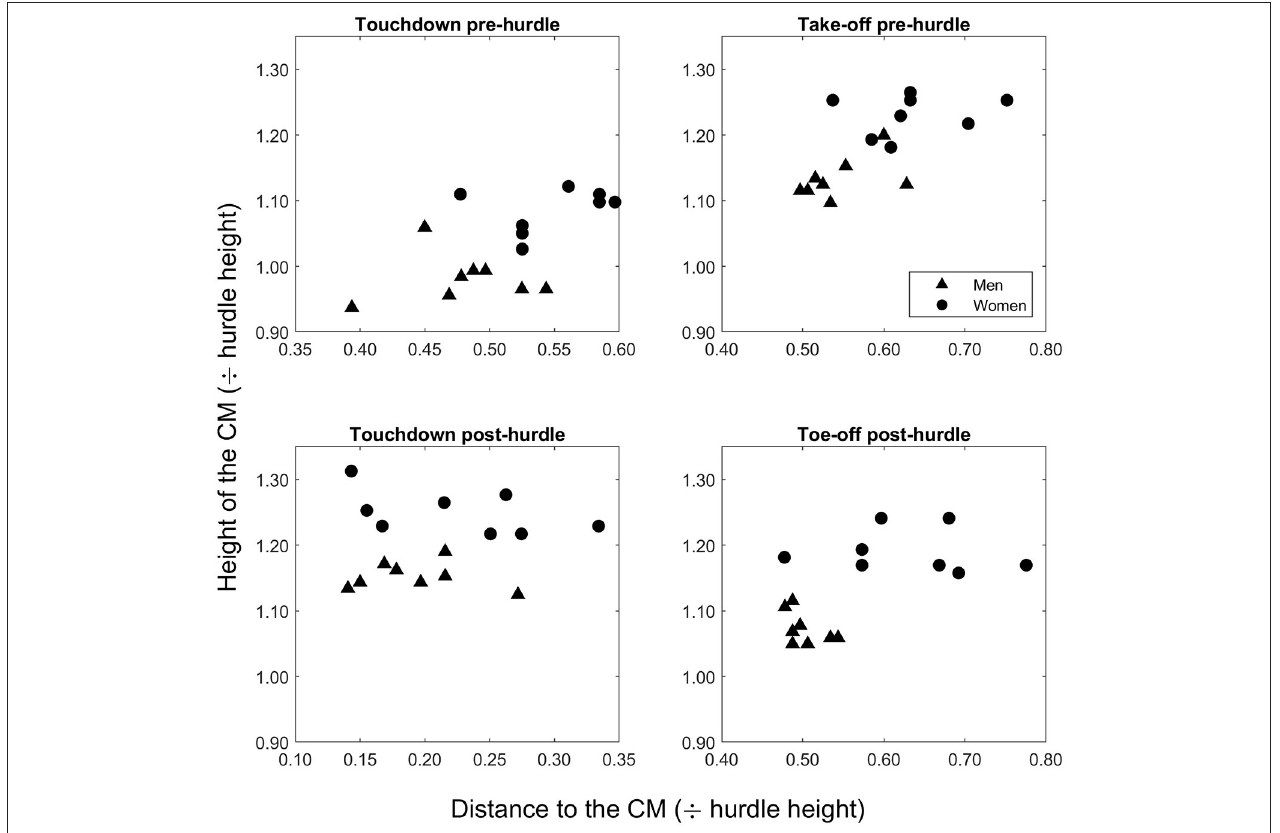
FIGURE 4 | Hurdle height-normalized values for the height of the CM for each man and woman at touchdown and toe-off in the stance phases pre- and post-hurdle.